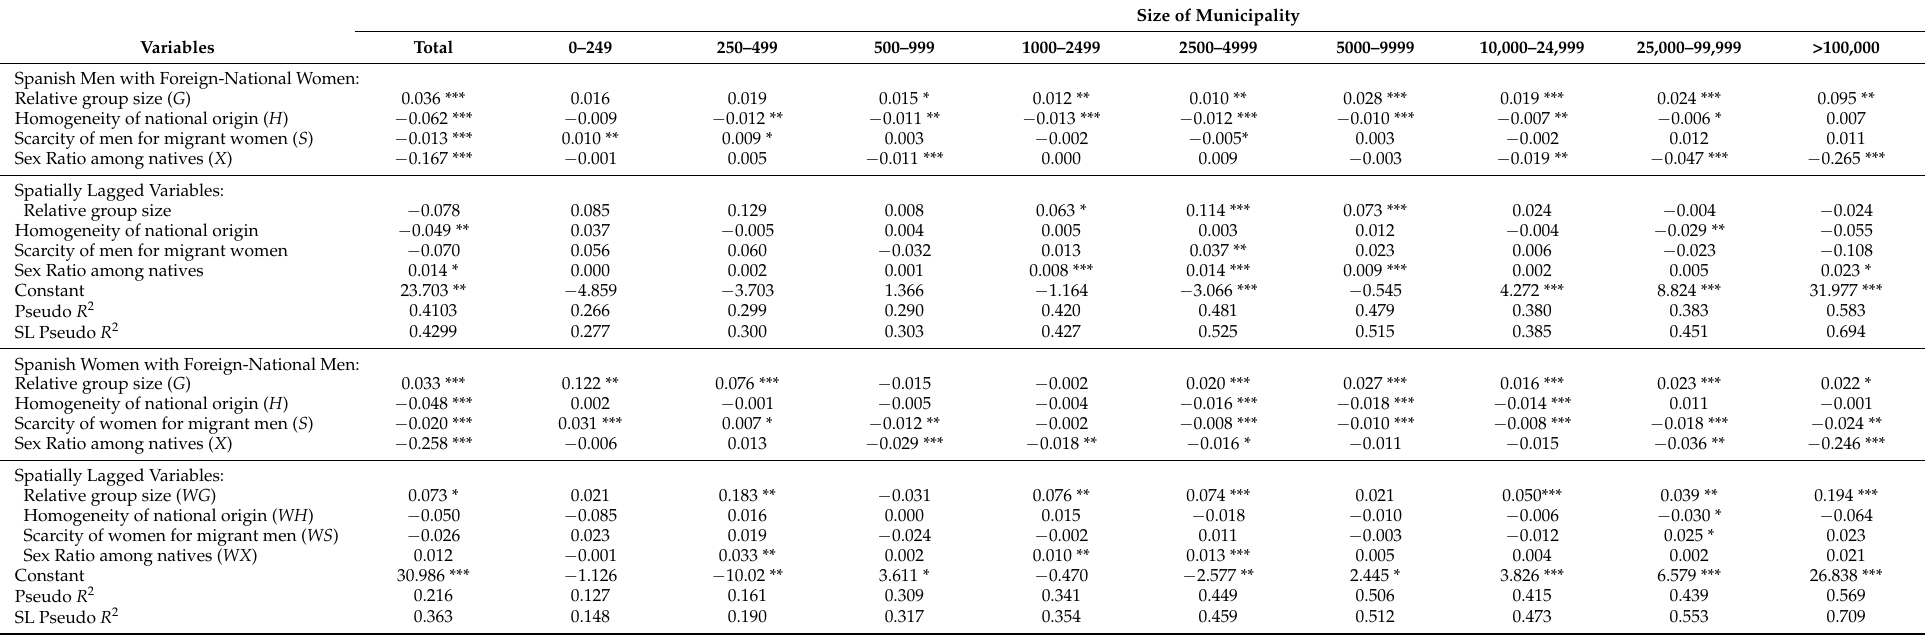
Table 3. Regression results for absolute intermarriage (Zero Inflated Poisson